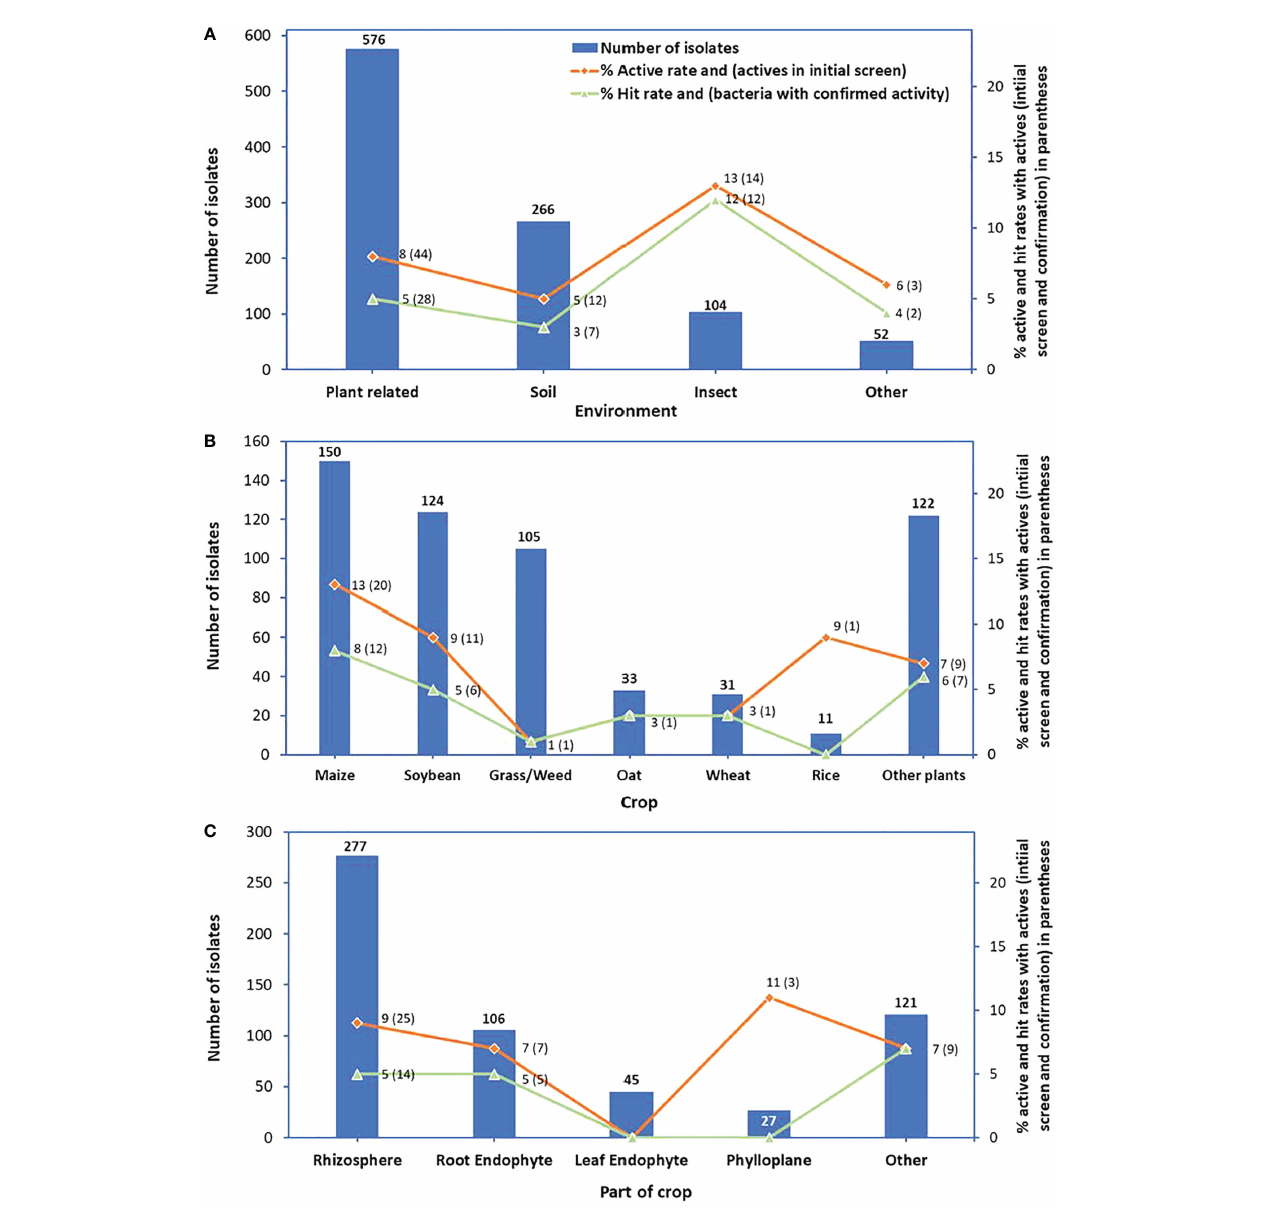
FIGURE 3 Numbers of bacterial isolates tested in the initial screen (bars), % active rates (red lines) and in parenthesis: numbers of active isolates from the initial screen, and % hit rates (green lines) and in parenthesis: numbers of bacteria with con fi rmed activity. Graph (A) represents the environment, (B) crop, and (C) part of the crop from which isolates were